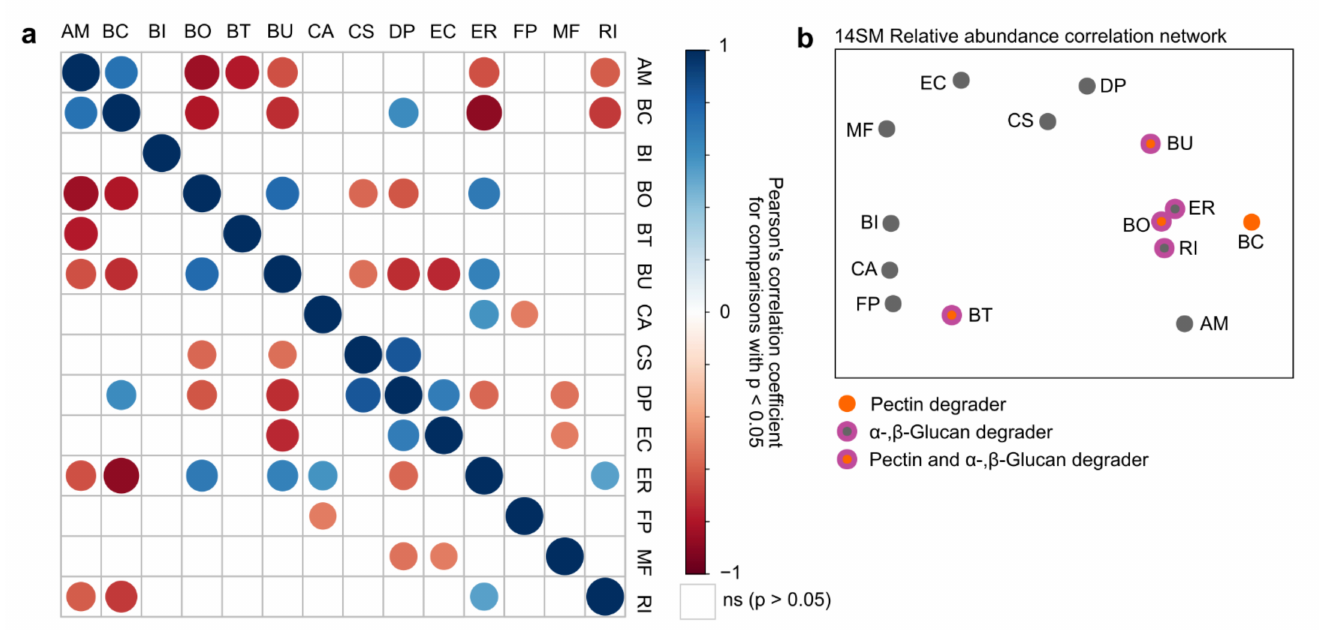
Figure 3. Correlations between relative abundances of 14SM community members. ( a ) Pairwise correlation between relative abundances of all strains as determined by using 16S rRNA gene sequencing data from all mice across all groups; Analysis performed using the “rcorr” function of the R package “Hmisc” and visualized using the “corrplot” function. Colored circles depict statistically significant correlations ( p < 0.05); empty squares represent non-significant correlation independent of the determined correlation coefficient R ; color intensity and circle size vary depending on the Pearson correlation coefficient R, with R = 1 (positive correlation) and R = − 1 (negative correlation) displayed with maximal circle size and color intensity. ( b ) Correlation network analysis using the “network_plot” function in the R “rcorr” package. Each circle represents one of the 14SM strains. Circles are positioned by multidimensional scaling of the absolute values of the correlations shown in panel a) to highlight correlation clusters in a two-dimensional graph. AM: A. muciniphila , BC: B. caccae , BI: B. intestinihominis